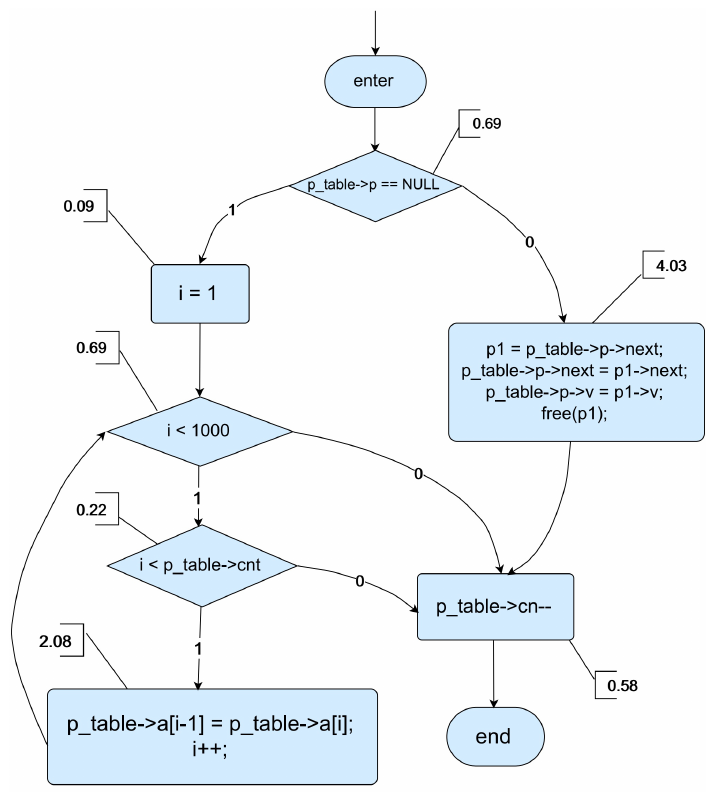
Figure 2. Control flow